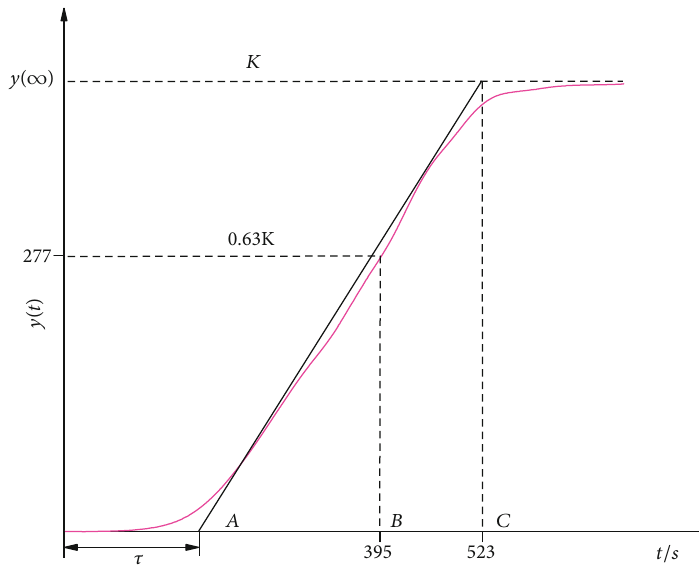
Figure 3: System step response. The distance AB is de fi ned as the system time constant T , and τ is dead time.